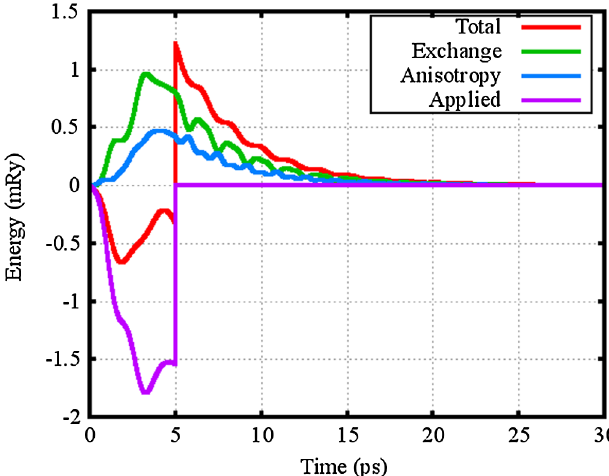
FIG. 5. Time evolution of different components of magnetic energy (exchange, anisotropy, applied), plotted along with the total magnetic energy. In this simulation the x component to the applied field was 3 T. Furthermore, H z ¼ 5 T and (cid:2) ¼ 0 : 02